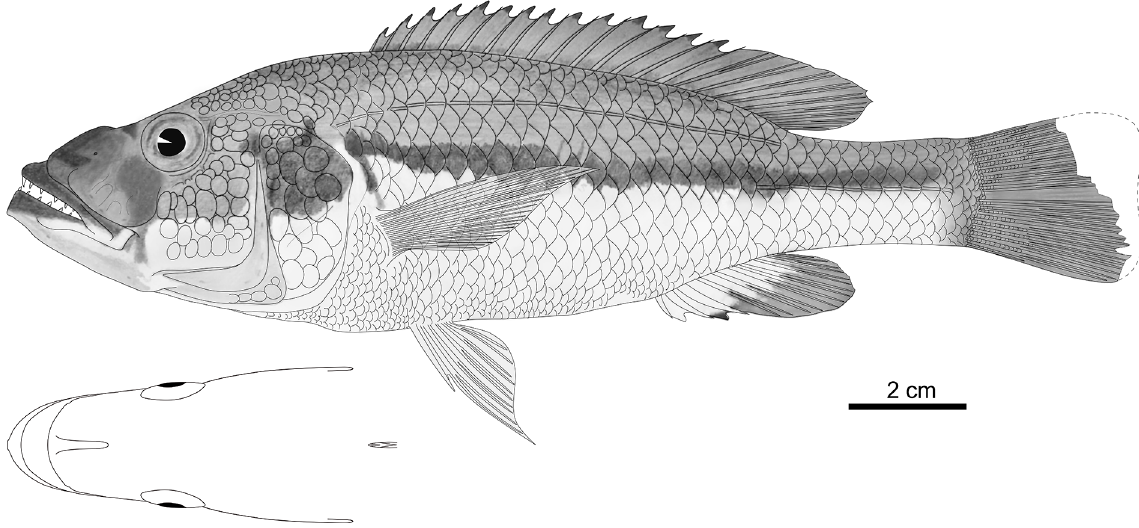
Fig. 5. Haplochromis latifrons sp. nov., holotype, ♀, 158.2 mm SL (RMCA 2018.008.P.0330). Drawn by N.